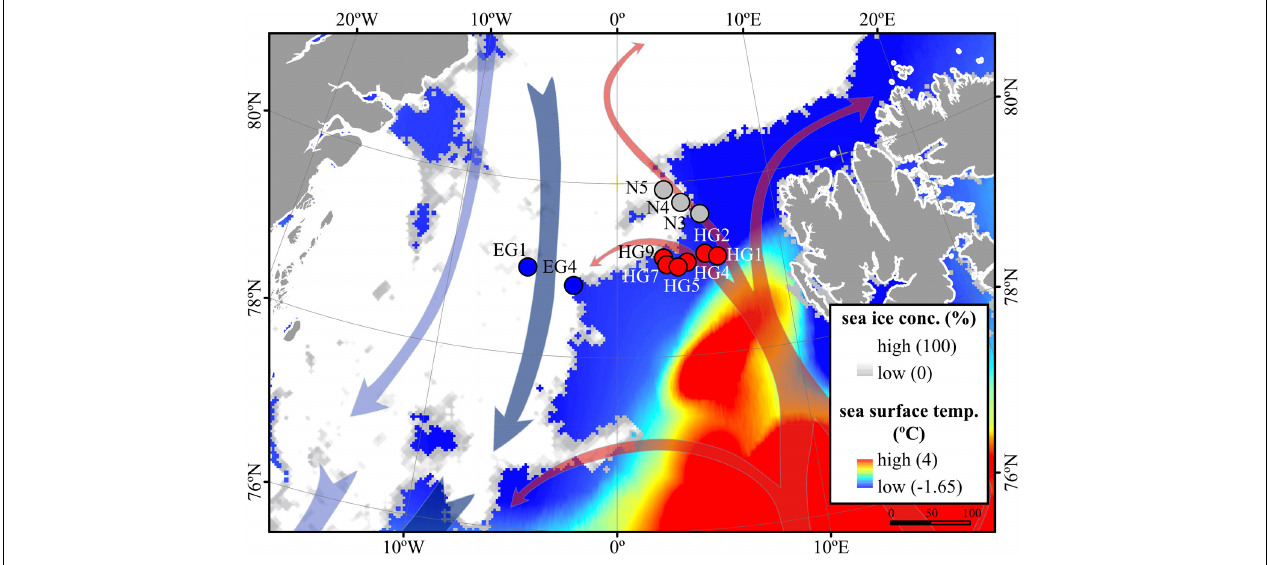
FIGURE 1 | Oceanographic overview of the Fram Strait, including the monthly mean of sea-ice cover and sea surface temperature during July 2016. The sea ice concentration is represented by inverted grayscale (gray = low, white = high). Arrows represent general directions of the West Spitsbergen Current (WSC) (in red) and the East Greenland Current (EGC) (in blue). Stations of water column sampling are indicated and colored according to their sea-ice conditions: ice-covered EGC (EG) stations–blue, ice-margin N stations–gray, ice-free WSC (HG) stations–red. The map was modified from (Fadeev et al.,